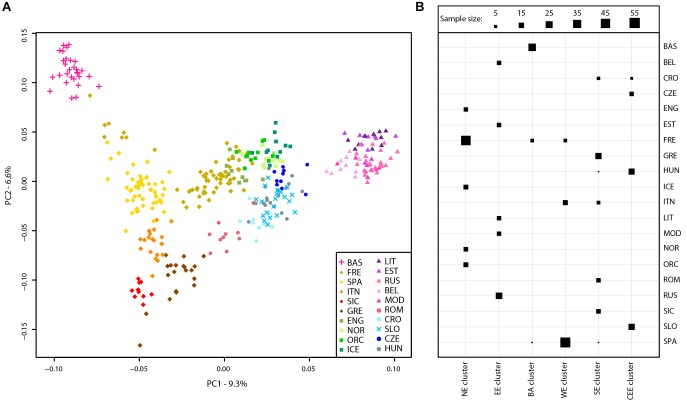
Population structure of Slovenian samples. (A) PCA of Slovenian samples with European populations (Slovenian_HO_EU dataset). For details regarding the populations included, see Supplementary Table 1. (B) Mclust clustering (Fraley et al., 2016) of European samples based on the first eight principal component of the PCA. The number of clusters is k = 6 as suggested by multiple clustering models, see Supplementary Figure 3. Horizontal lines represent populations while vertical lines represent the six clusters. The size of each square is proportional to the number of individuals assigned to each cluster as shown in the figure legend. For population acronyms see Supplementary Table 1. NE, Northern European cluster; EE, Eastern European cluster; BA, Basque cluster; WE, Western European cluster; SE, Southern-European cluster; CEE, Central-Eastern European cluster.